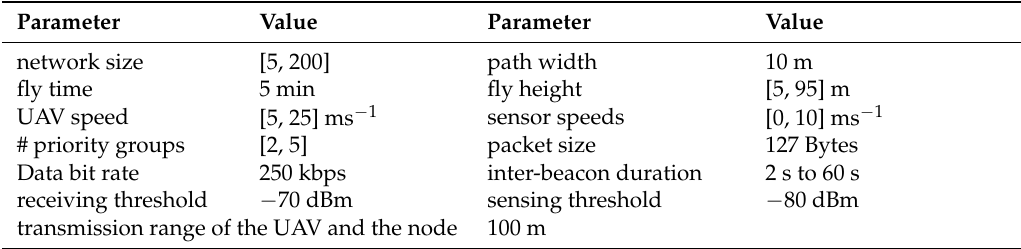
Table 4. Simulation